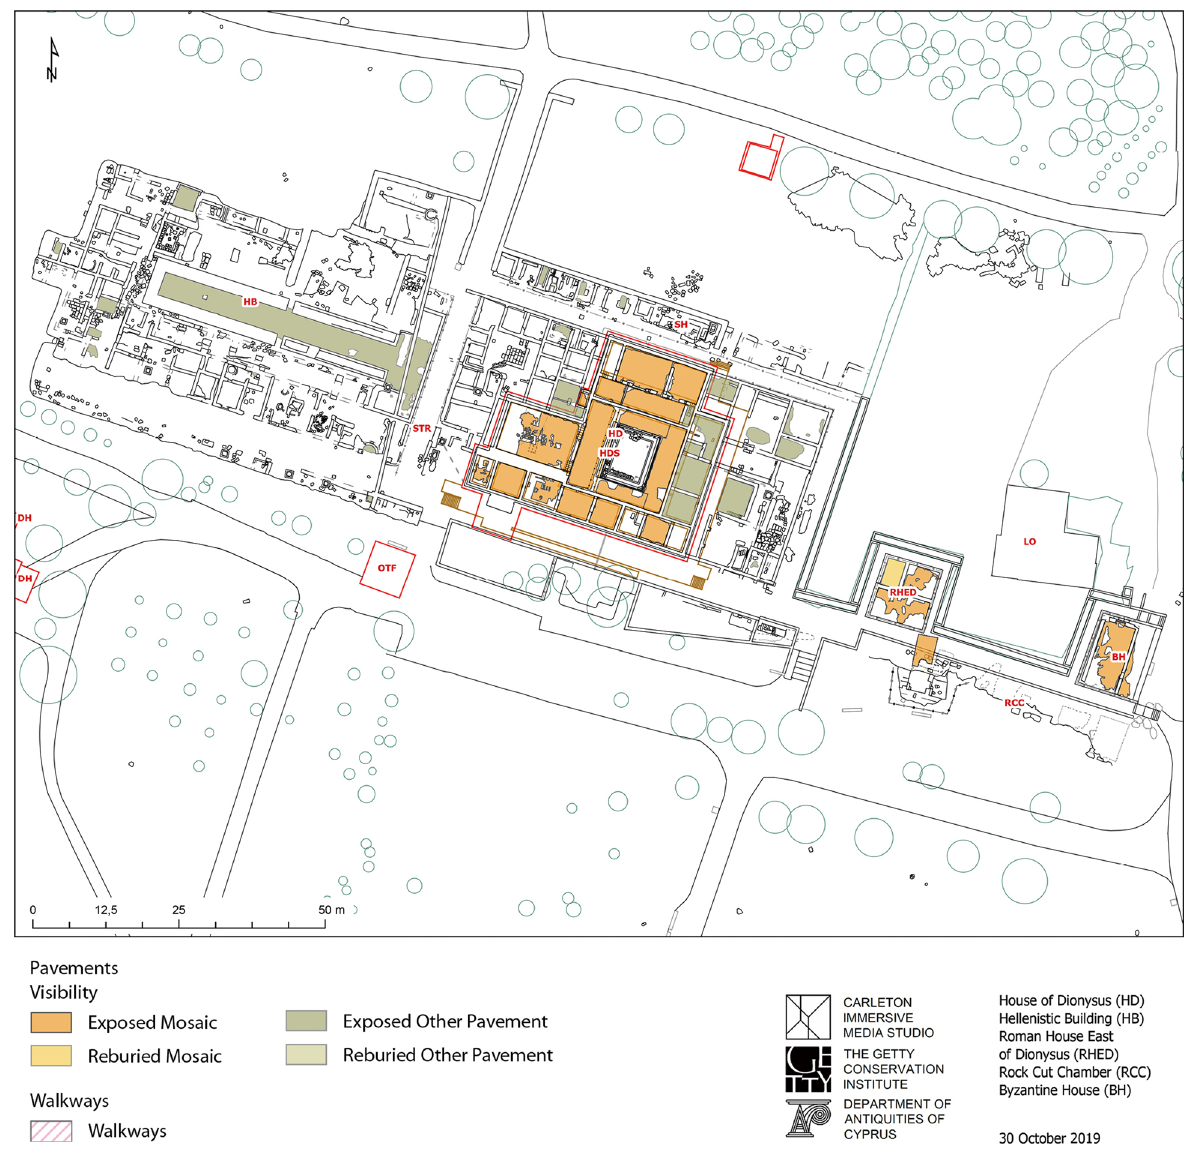
Fig. 14 Example of a measured drawing integrated into the GIS (Source: the